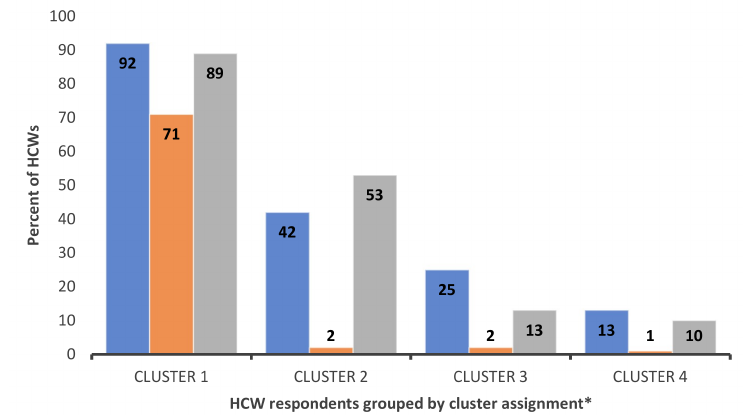
Figure 1. HCW support of COVID-19 conspiracy theories by cluster. Blue: HCWs that believe COVID-19 is a manmade virus; Orange: HCWs that believe COVID-19 is a hoax; Grey: HCWs that believe the impact of COVID-19 is exaggerated; * Cluster derivation and definitions are provided in surrounding text.